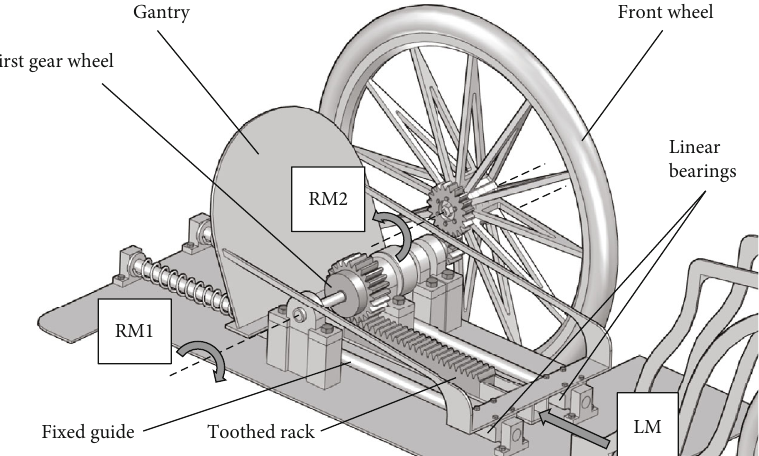
Figure 3: The gantry drive in the horizontal bike (general